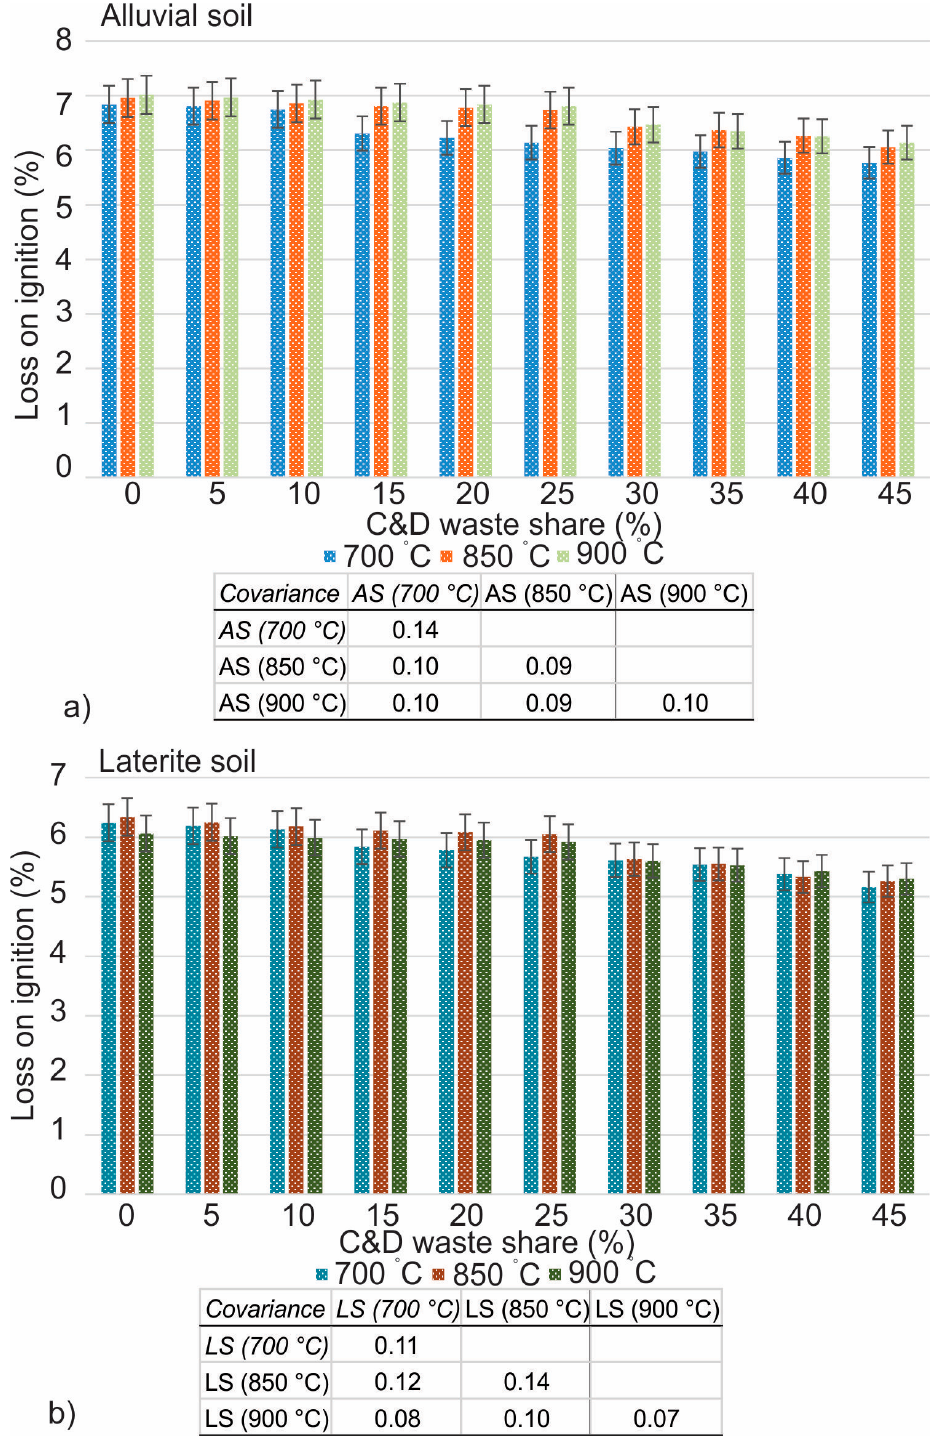
Figure 9. Loss on ignition of mixed C&D waste in alluvial ( a ) and laterite ( b ) soils.